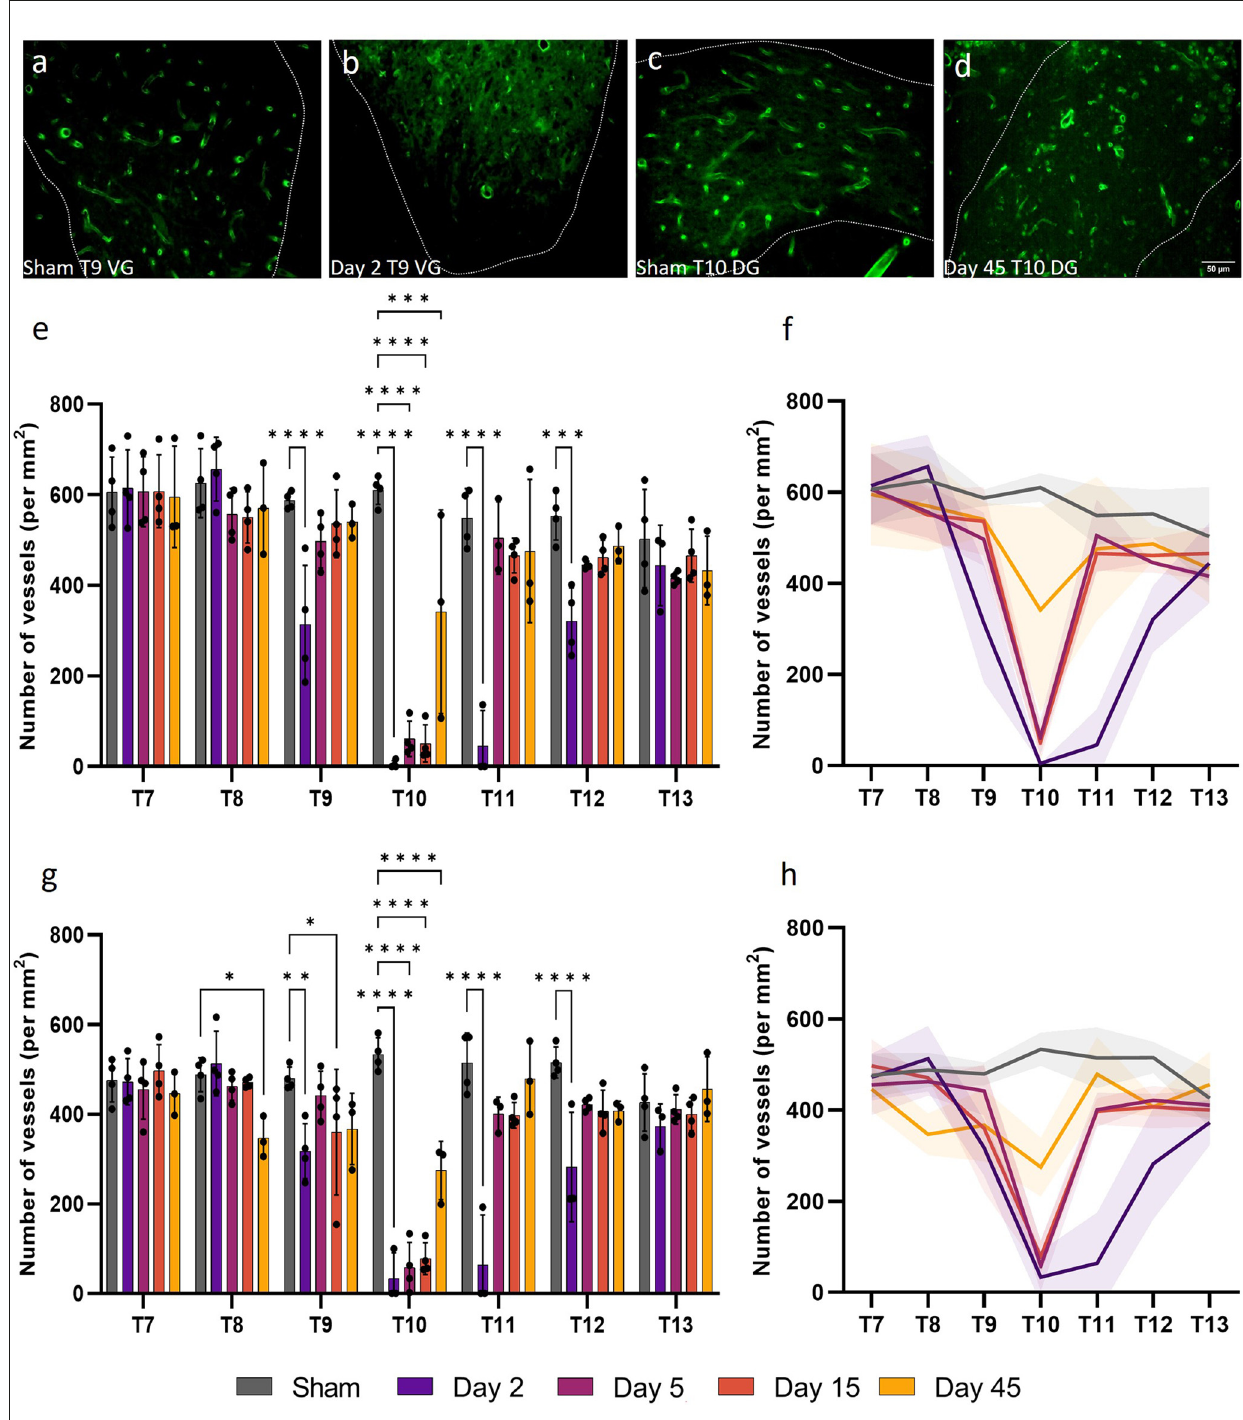
FIGURE1 Vessel density (the number of vessels per mm 2 ) in the grey matter significantly decreased following spinal cord injury. Microvessel density [visualised by RECA-1 staining (green)] significantly reduced in the ventral grey (VG) matter of T9 at day 2 ( P < 0.0001) (B) compared to sham cords at the same level (A) . At day 45 at T10, vessel density also significantly decreased in the dorsal grey (DG) matter ( P < 0.0001) (D) compared to sham (C) . Vascular rarefaction was significant up to two spinal segments away from the injury epicentre at T10 in both the ventral (E,F) and dorsal (G,H) grey matter. Trend lines (F,H) show the pattern of changes over time across seven spinal segments. Scale bar = 50 µ m (A–D) . ∗ P < 0.05, ∗∗ P < 0.01, ∗∗∗ P < 0.001, ∗∗∗∗ P < 0.0001. Error bars ± SD. n = 3/4 for all groups.